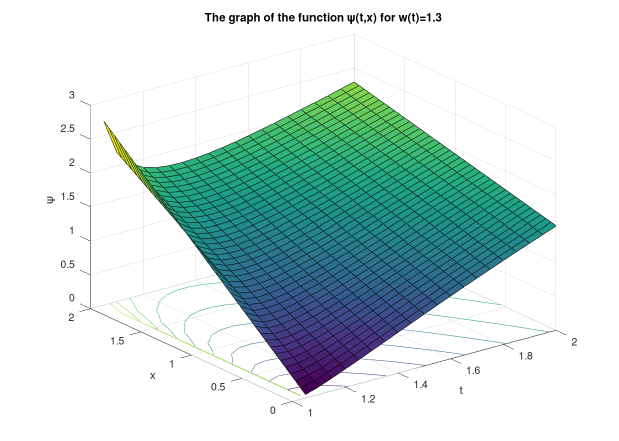
Figure 1. The graph of the function ψ for w ( t ) = 1.3 on I 1 = [ 1,2 ] .